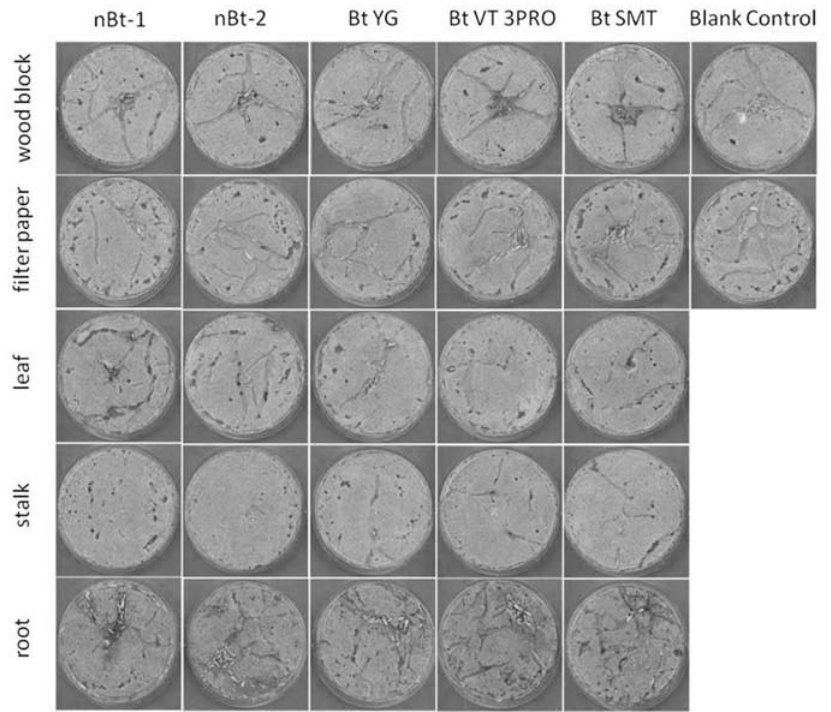
Fig. 4. Tunneling pattern of C, formosanus in the bottom sides of Petrie dishes containing food sources withBt and non-Bt plant tissue